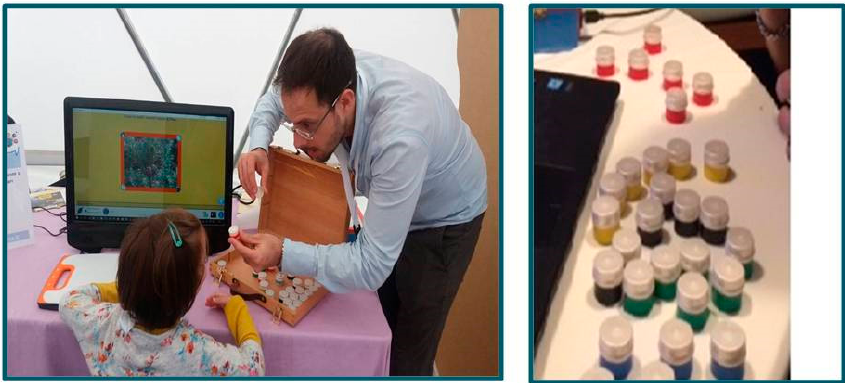
Figure 3. SNIFF hardware and software system: on the left side, an interaction with a child; on the right, the colored jars with the smells.